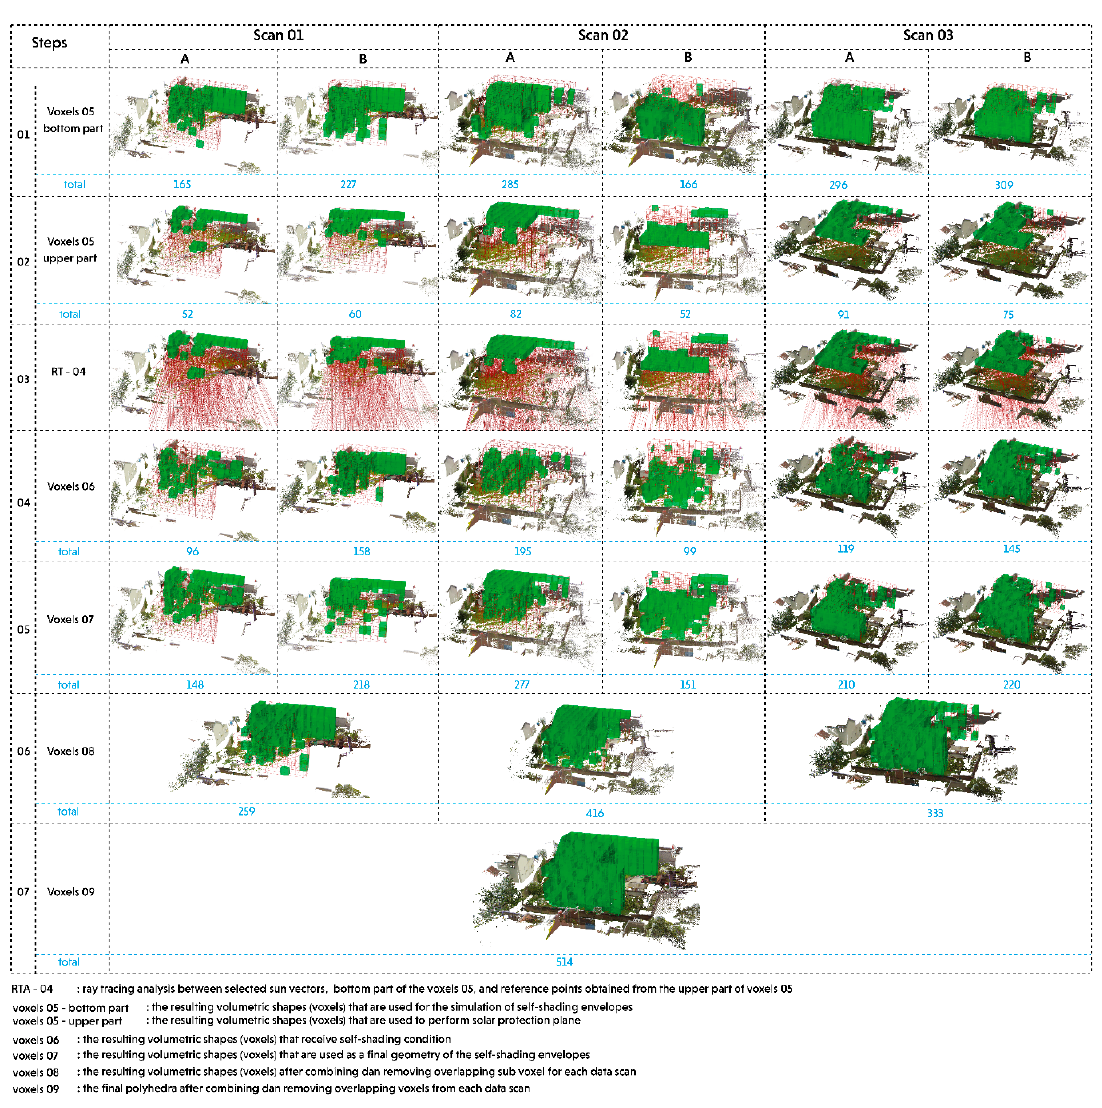
Figure 14. Geometric configuration of subtractive shading envelopes.